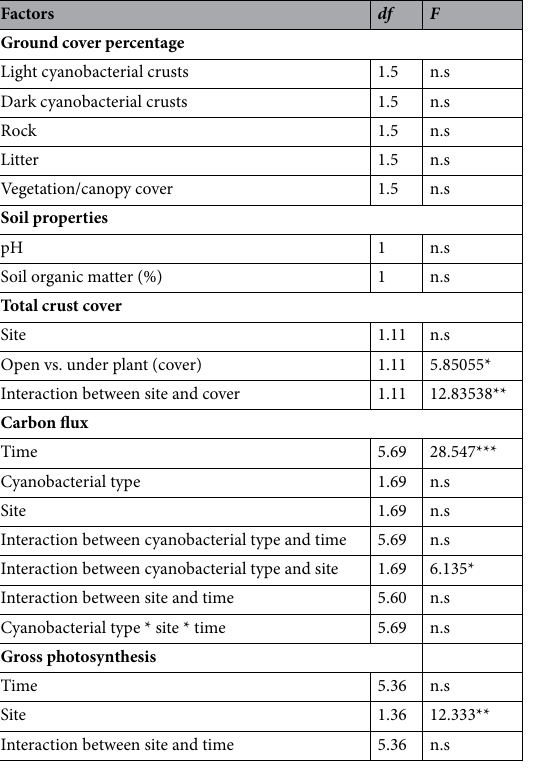
Table 2. The degrees of freedom, F value, and statistical significance from a single factor ANOVA test determining differences between ground cover percentages, total crust cover, and soil properties at urban and non-urban sites. Statistical differences between factors for carbon flux and gross photosynthetic rates were determined using a general linear model, and the df, F, and statistical differences are shown below. * P < 0.05, ** P < 0.01, *** P < 0.001, n.s. not